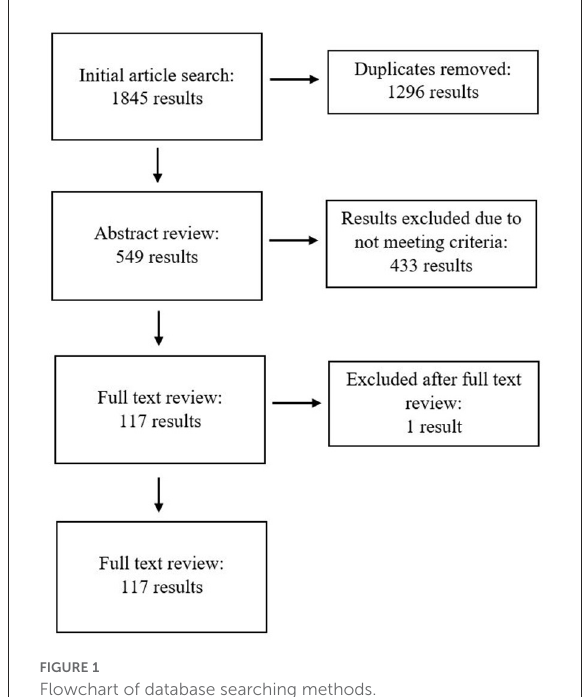
FIGURE1 Flowchart of database searching